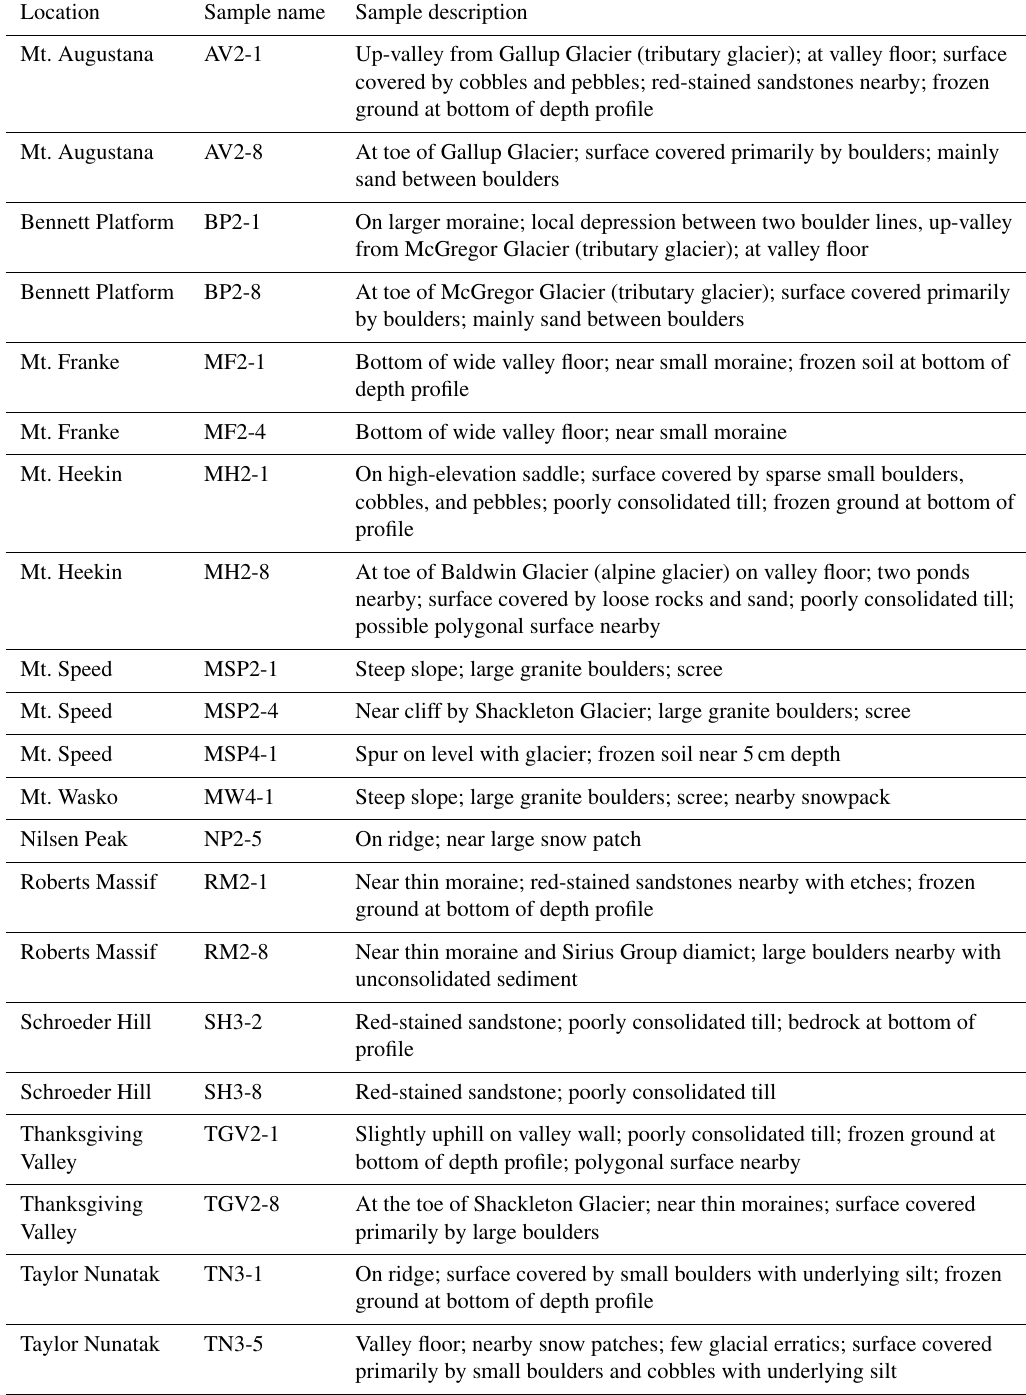
Table 2. Surface features of the sample locations from the Shackleton Glacier